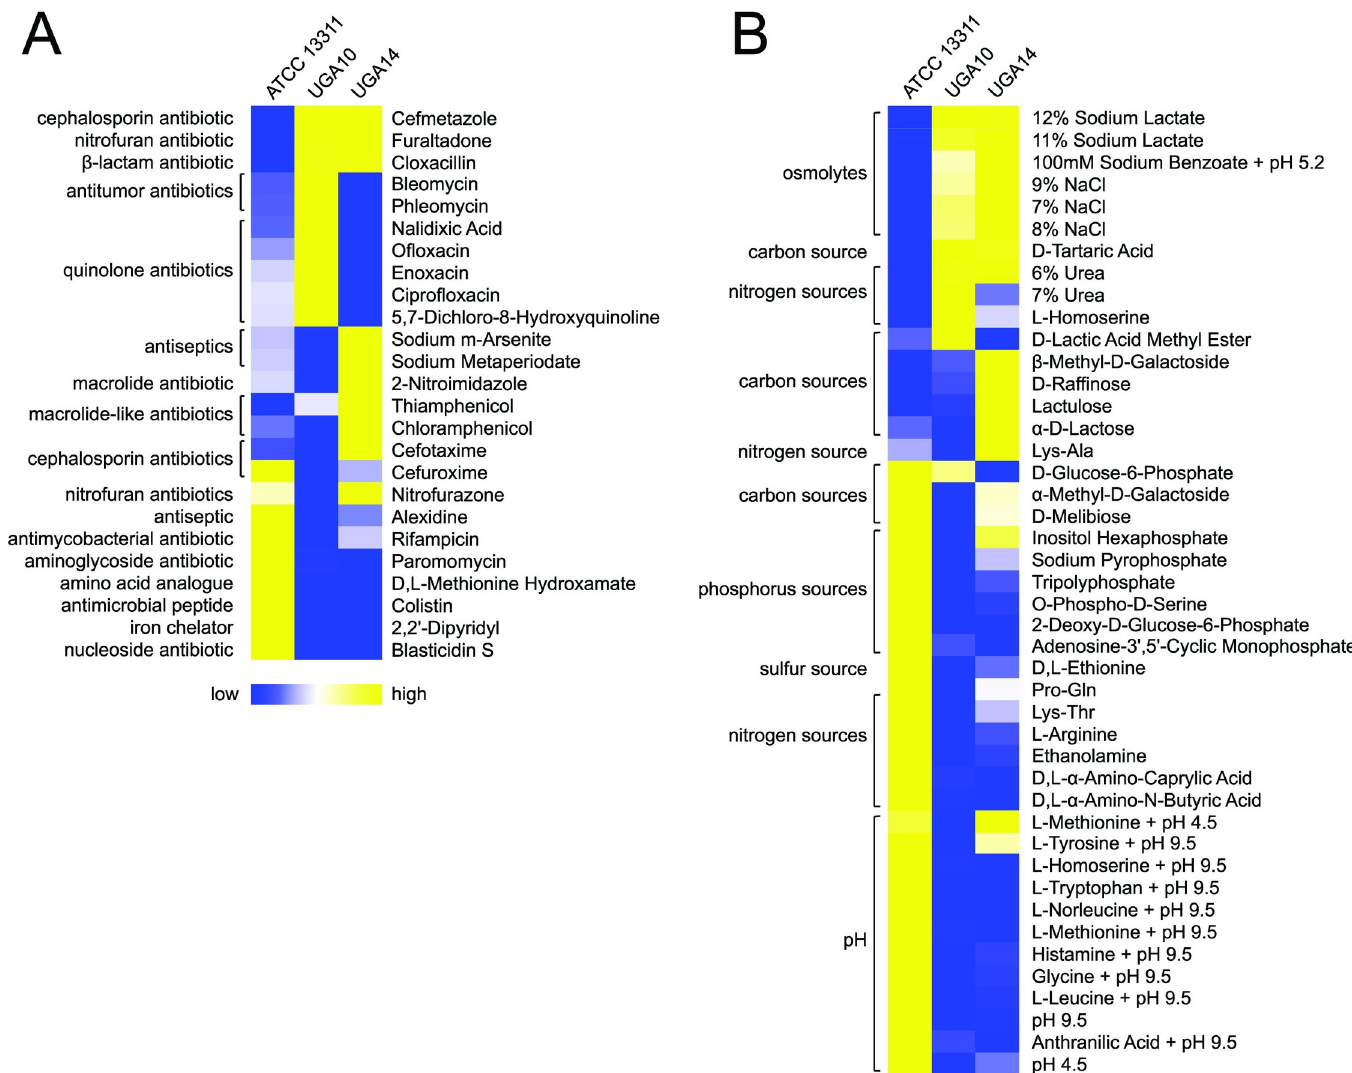
Fig 4. Heatmaps of selected Biolog phenotypic array profiles for S . Typhimurium strains. Data are grouped into categories based on their biological roles as either (A) chemicals and antimicrobials or (B) nutrients. S . Typhimurium reference strain ATCC 13311 (antibiotic susceptible and non-invasive) was compared to isolates UGA10 and UGA14. Each column represents the area under the curve (AUC) values computed by adding all OmniLog values at all time points. All raw AUC data is available in S1 Data . Blue represents low relative growth in a given condition while yellow represents high growth.